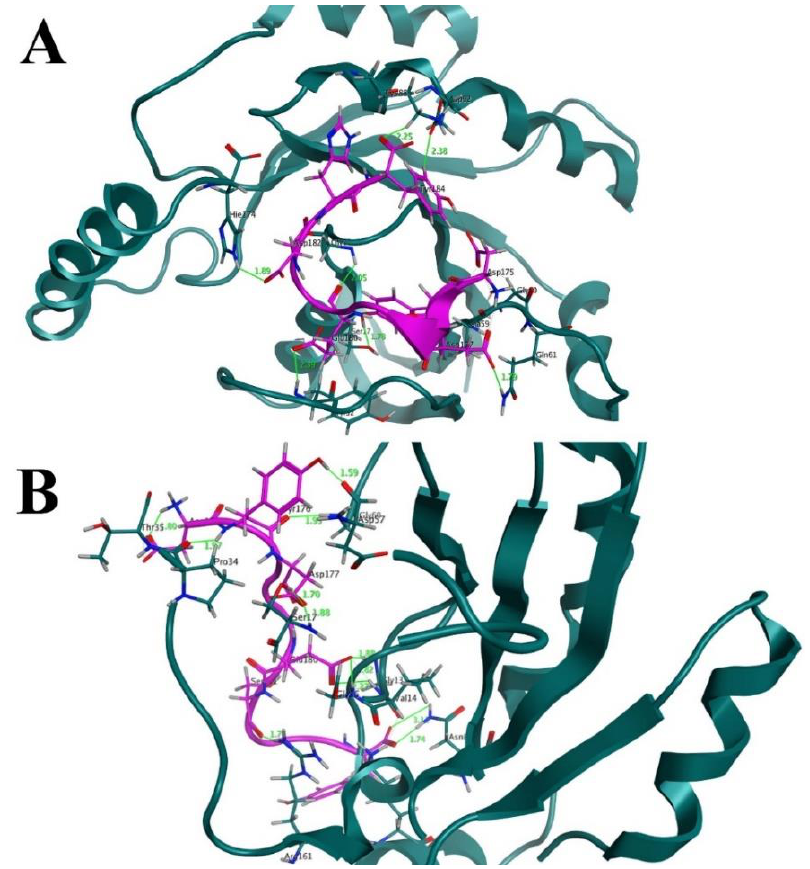
Figure 5. ( A ) Before MD simulation, the binding interface revealed that the designed peptide, such as (S. No 1) L175D-G180E-K183H, formed 7 hydrogen bonds with the active residues of K-Ras receptor. A hydrogen bond could be seen as a solid line in green. ( B ) After 200 ns of MD simulation, the binding interface showed that the number of hydrogen bonds increased to 12 H-bonds between the residues of (S. No 1) L175D-G180E-K183H peptide (designed peptide) and residues of